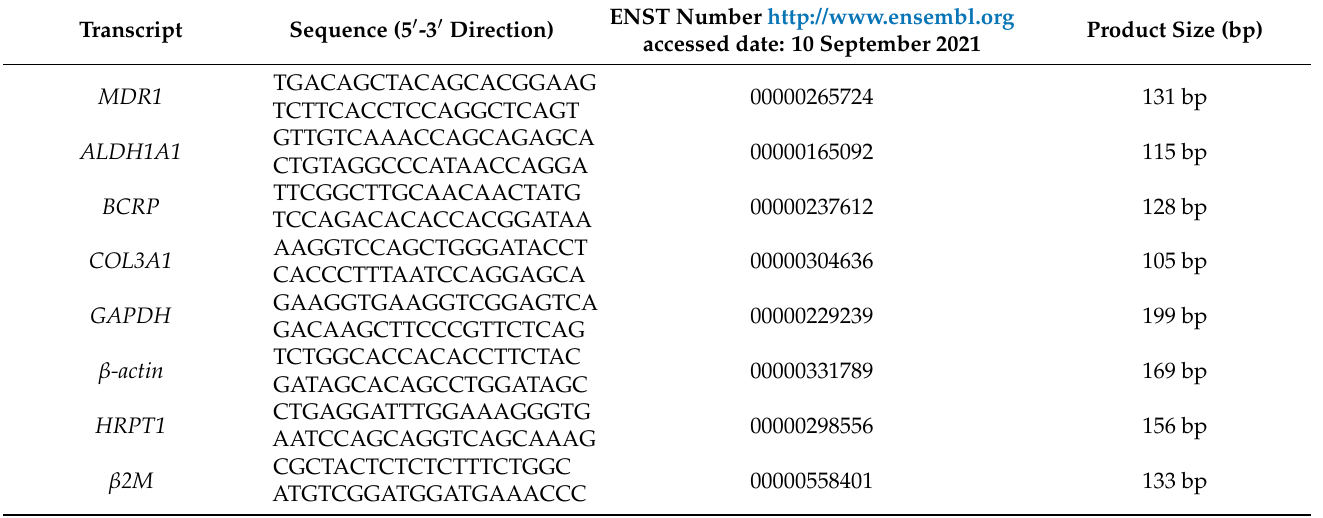
Table 3. Oligonucleotide sequences used for RQ-PCR